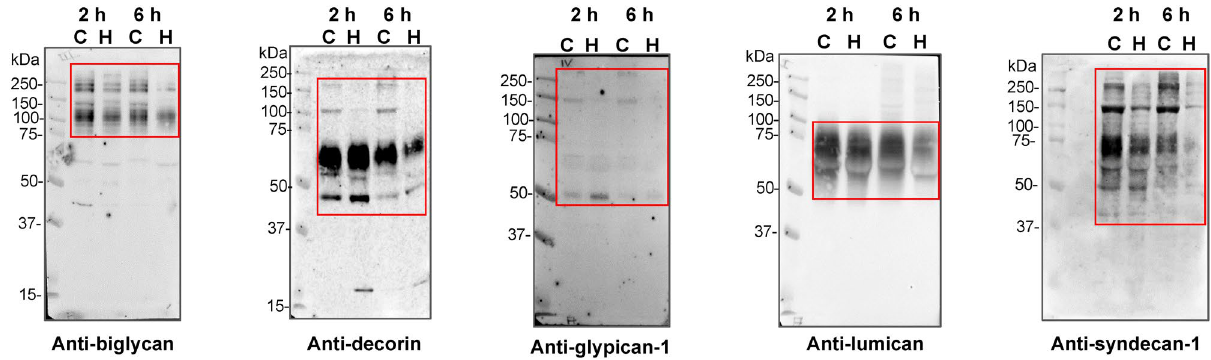
Figure 4. Degradation of glycocalyx-related proteoglycans in the mouse skin injected with HF3, as shown by Western blot analysis. Protein samples (30 μg) extracted from control skin (C) or skin injected with HF3 (H) after 2 h and 6 h, as described in “Materials and methods”, were immunostained with anti-biglycan, anti- decorin, anti-glypican-1, anti-lumican and anti-syndecan antibodies. Red rectangles indicate main protein bands recognized by the